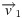
Model parameter estimation for a sample ON cell stimulated at 20 Hz.A) STC analysis revealed four significant components. Shown in black are all the eigenvalues, and the grey region denotes the null distribution of eigenvalues representing a 95% confidence interval. Eigenvalues that lie outside this region are considered significant (arrows). B) Stimuli along the generator function were plotted against the number of spikes that each stimulus produced (grey dots). These were binned along g(S) such that each bin contained 200 stimuli, from which the mean of each bin was computed (red dots with SE bars). A sigmoidal nonlinear function was fit to the binned data (black dashed curve). For comparison, a log-exponential fit is also shown (grey dashed curve). C) A maximum-likelihood estimation was carried out using the four components from A to initialize the estimation. The resulting excitatory components (v→1 and v→2) and suppressive components (v→3 and v→4) are shown. The green dots in the plots denote the approximate cell location. Above each plot is a histogram showing the input stimuli (black) and the ratio of responses to stimuli (grey) when projected onto each component.